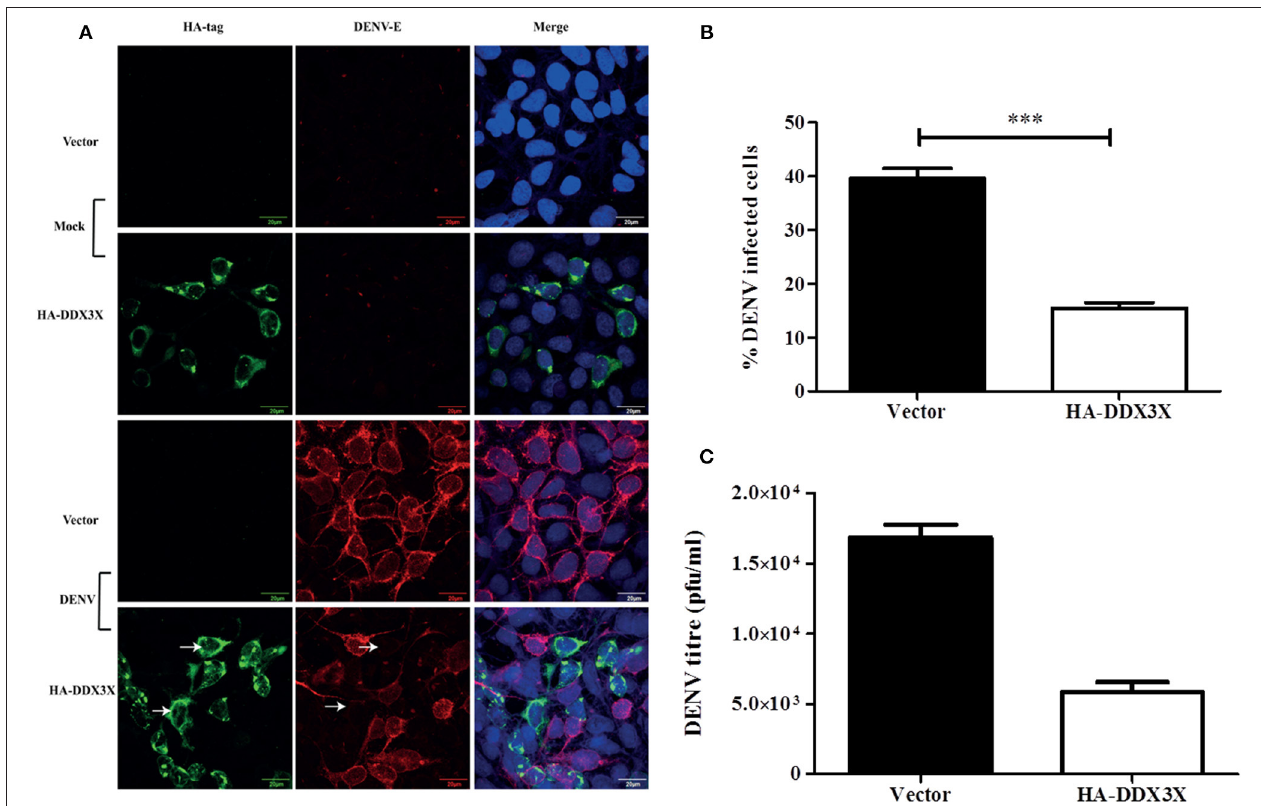
FIGURE 5 | DDX3X overexpression suppresses dengue infection. (A) HA-DDX3X plasmid or the vector was transfected in HEK293T cells. 24h p.t. cells were infected with DENV at 5 MOI. Cells were fixed and stained for dengue envelope and HA at 24h pi. (B) Percentage of infected cells was counted in ten fields each in three independent experiments ( ∼ 3000 cells were counted) (C) Viral titres were estimated by plaque assay at 24h pi. Data is represented as mean ± SEM. *** P <